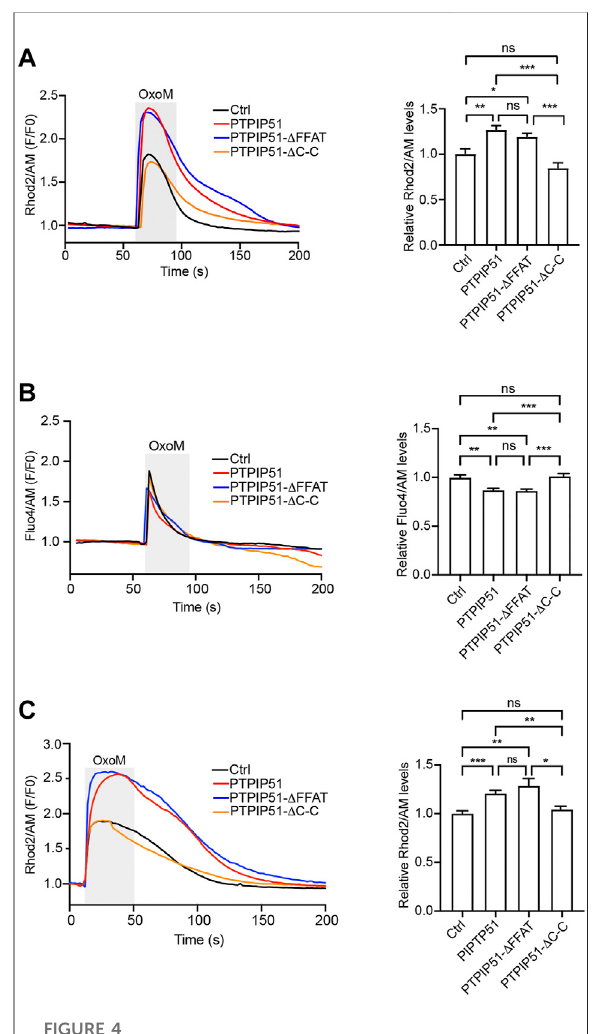
FIGURE 4 Deletion of the PTPIP51 coiled-coil domain but not FFAT motif disrupts IP3 receptor mediated delivery of Ca 2+ to mitochondria. SH-SY5Y cells were transfected with EGFP (A,C) or DsRed (B) plus either control vector (Ctrl), PTPIP51-HA, PTPIP51- Δ FFAT-HA or PTPIP51- Δ C-C-HA. The release of Ca 2+ was induced by treatment of cells with oxotremorine-M (OxoM). Mitochondrial (A,C) and cytosolic (B) Ca 2+ levels weredetected using Rhod2/AM and Fluo4/AM respectively. (A) Representative Rhod2/AM fl uorescence traces in the presence of external Ca 2+ are shown on the left with OxoM treatment (depicted by the shadedarea);normalisedpeakvaluesareshowninthebarcharton the right. Expression of PTPIP51-HA or PTPIP51- Δ FFAT-HA induced similar signi fi cant increases in peak mitochondrial Ca 2+ levels compared to control. Expression of PTPIP51- Δ C-C-HA had no signi fi cant effect on mitochondrial Ca 2+ levels compared to control. Data were analysed by Welch ANOVA and Games- Howell ’ s post hoc test. N = 52 – 67 cells from three independent experiments. Error bars are s. e.m, ns, not signi fi cant; * p ≤ 0.05, ** p ≤ 0.01, *** p ≤ 0.001. (B) Representative Fluo4/AM fl uorescence traces are shown on the left with OxoM treatment (depicted by the shaded area); normalised peak values are shown inthebarchartontheright.ExpressionofPTPIP51-HAorPTPIP51- Δ FFAT-HA induced similar signi fi cant decreases in peak cytosolic Ca 2+ levelscomparedto control. Expression ofPTPIP51- Δ C-C-HA had no signi fi cant effect on cytosolic Ca 2+ levels compared to control. Data were analysed by Welch ANOVA and Games-